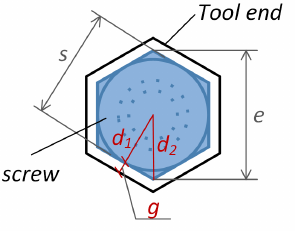
Figure 9. Engagement of the tool and